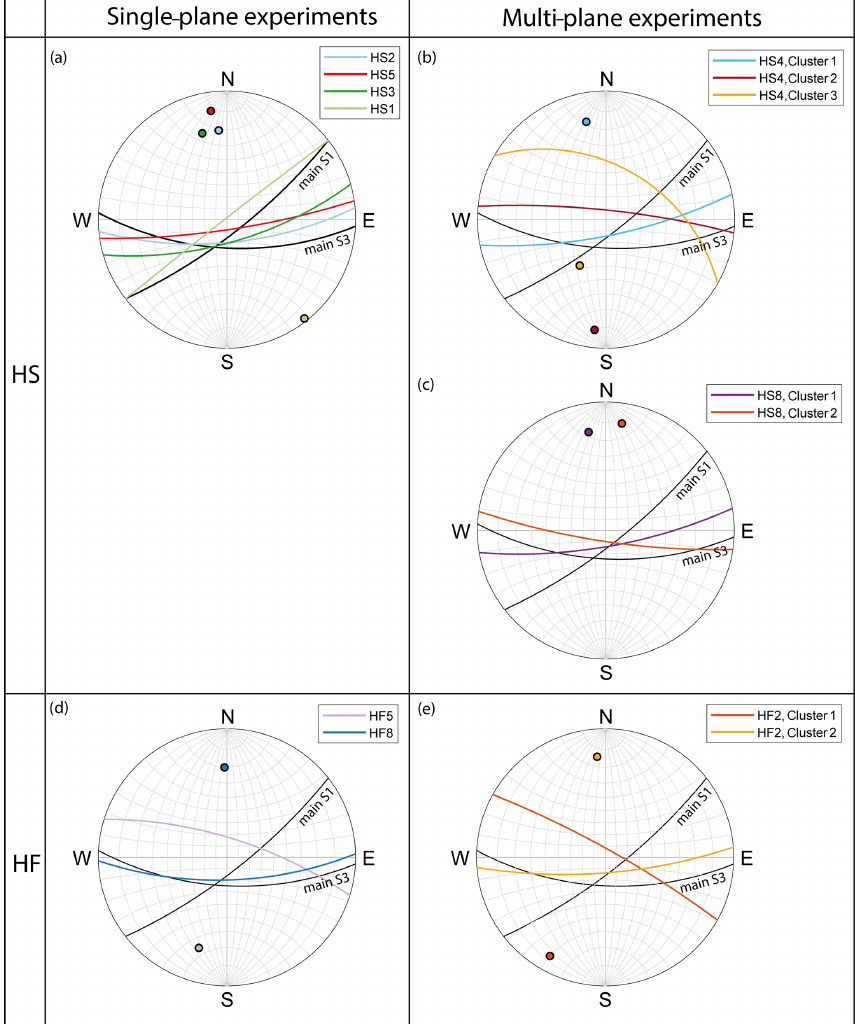
Figure 7. Orientation of fitted planes and corresponding pole points through seismic clouds in lower-hemisphere stereographic plots, in- cluding main orientations of shear zones S1 and S3 observed in the tunnels. Plots are as follows: (a) for HS1, 2, 3, and HS5 for which a single-planar orientation of stimulation was identified; (b) for the three visually identified seismic clusters of injection HS4; (c) for the two clusters of injection experiment HS8; (d) for HF5 and HF8, for which a single and planar orientation of stimulation was identified; and (e) for the two visually identified seismic clusters of injection